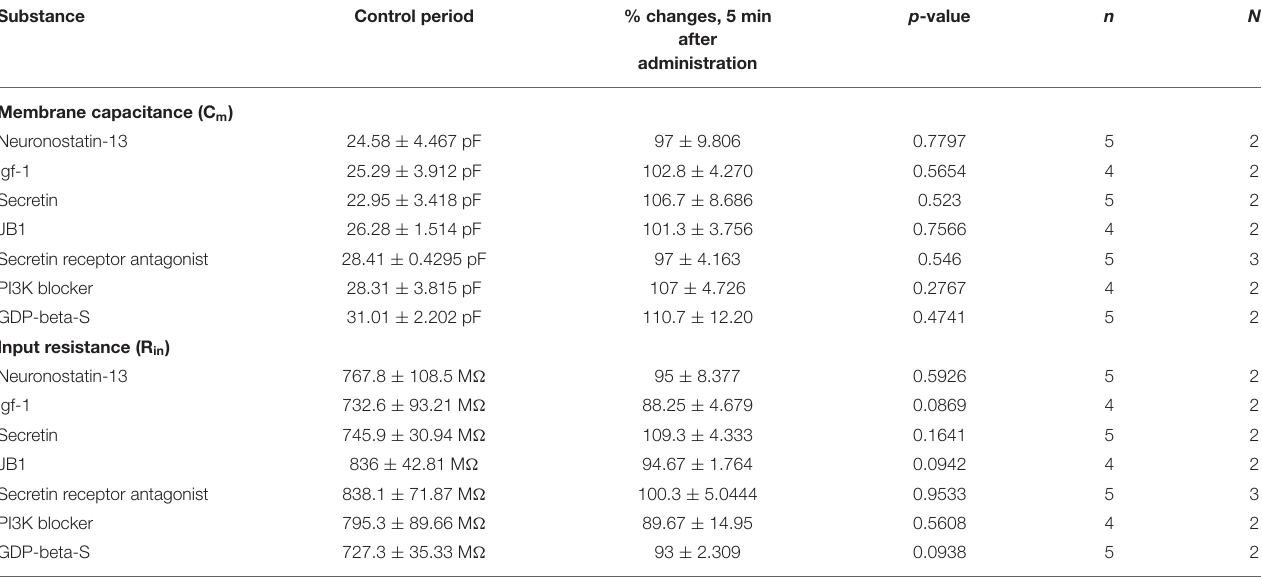
p -value N after administration